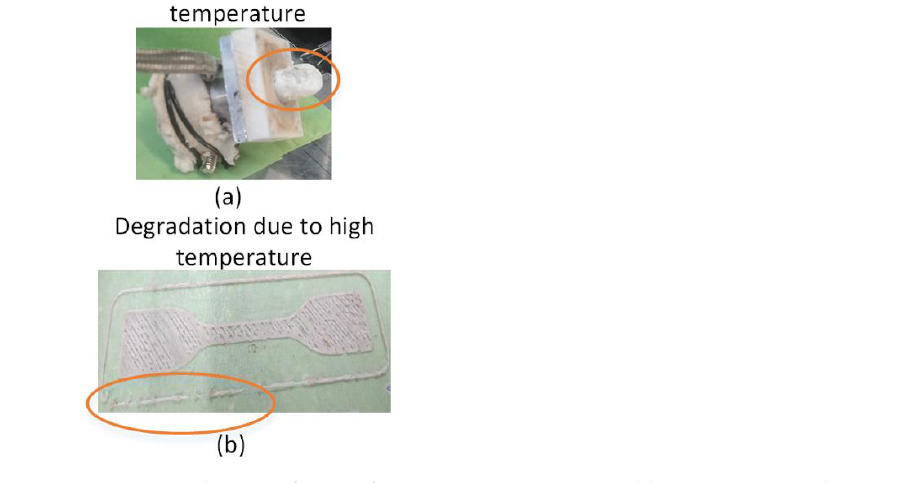
Figure 2. Selection of range for printing temperature: ( a ) 155 °C causes clogging, and ( b ) 177 °C causes thermal degradation.